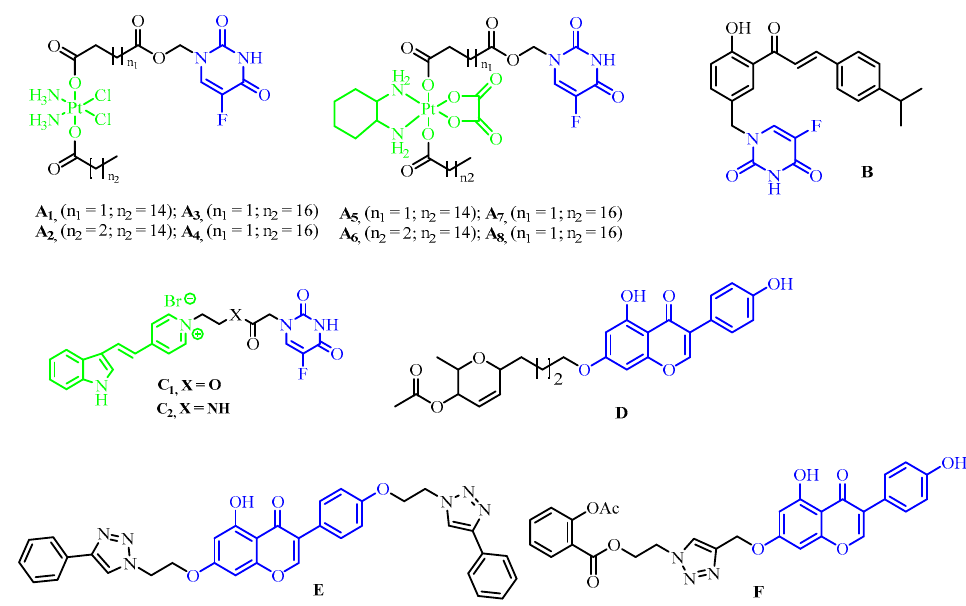
Figure 1. Hybrid molecules derived from 5-FU or genistein with anticancer activity.